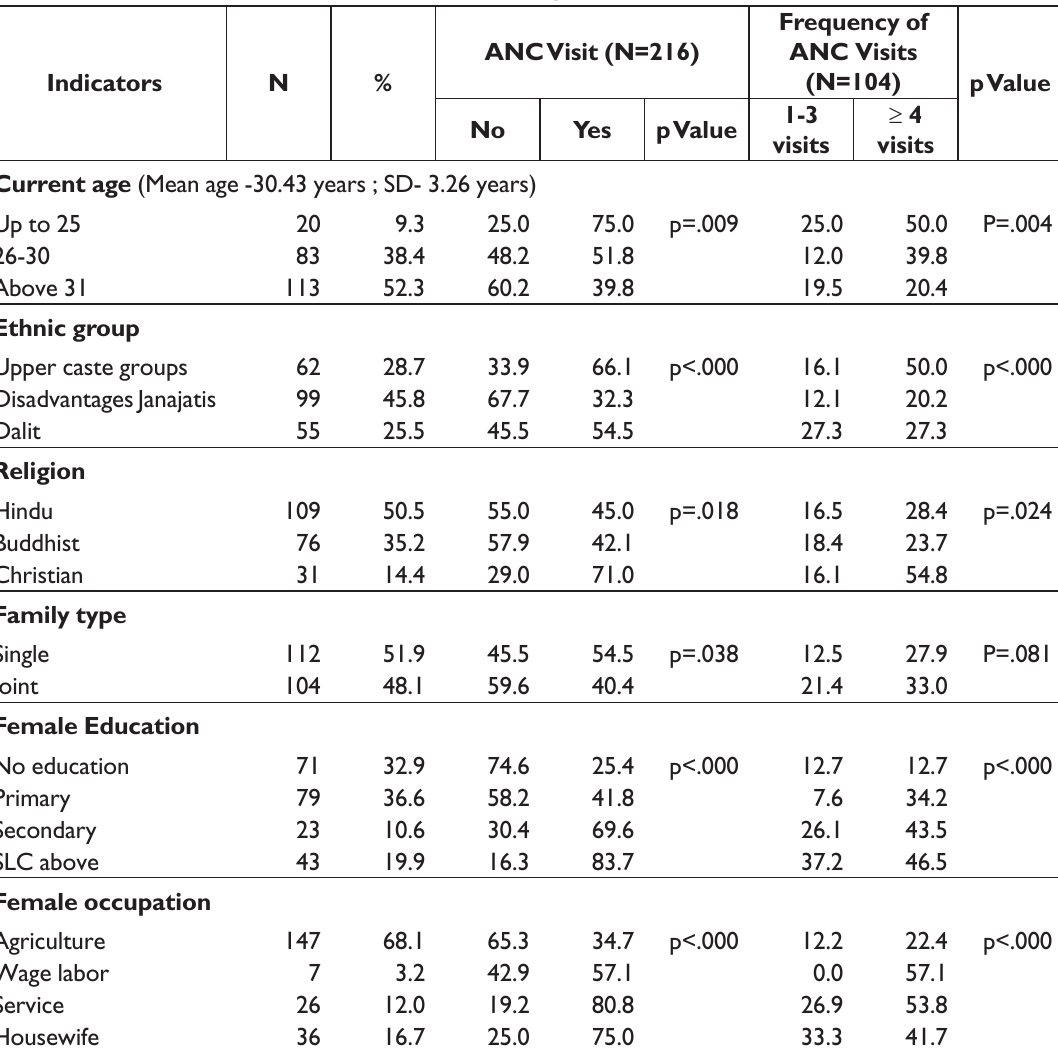
Association Between Study Factors of Respondents and Ante Natal Care Visits ANC Visit Indicators N %